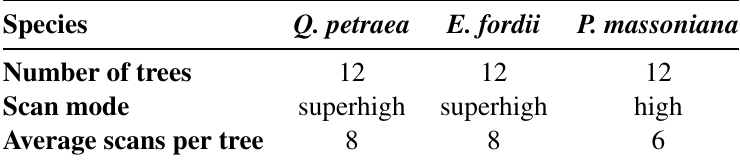
Table 2. Overview of the applied sample and scan parameters used for data